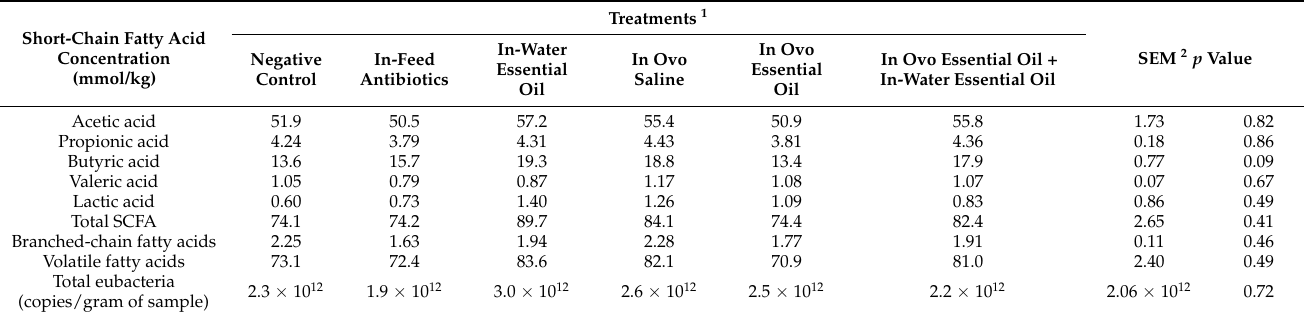
Table 1. Effect of essential oil delivery route on ceca short-chain fatty acid concentration (SCFA) and total eubacteria (copies/gram of sample) in broiler chickens.